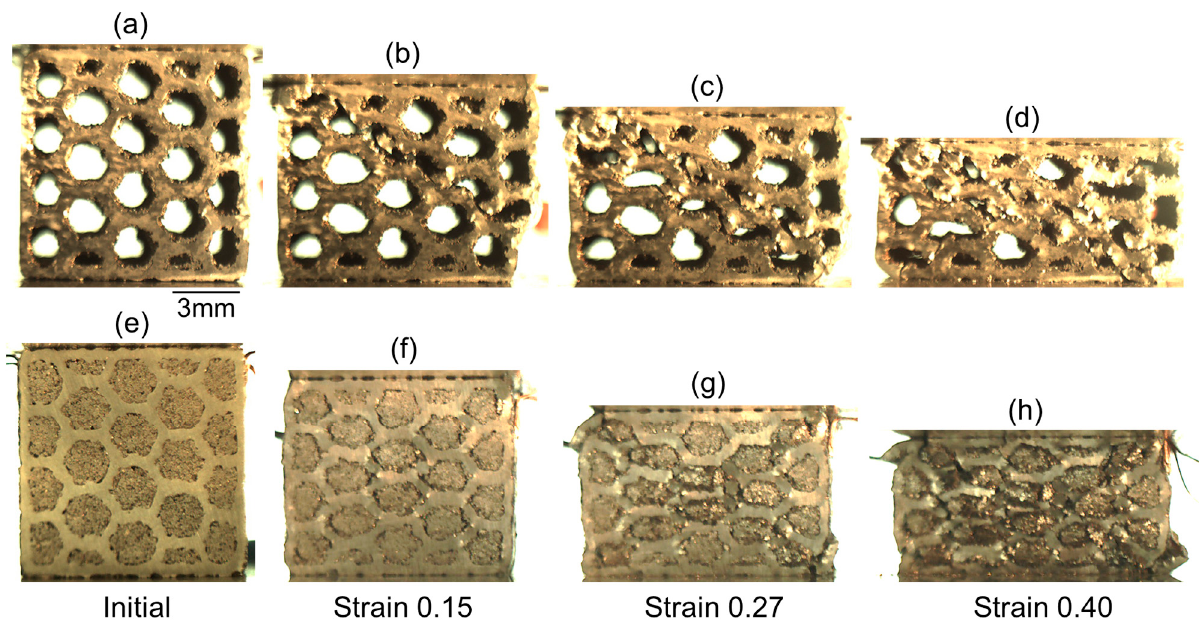
Figure 6. Compressive deformation behavior of ( a – d ) porous and ( e – h ) composite specimen.